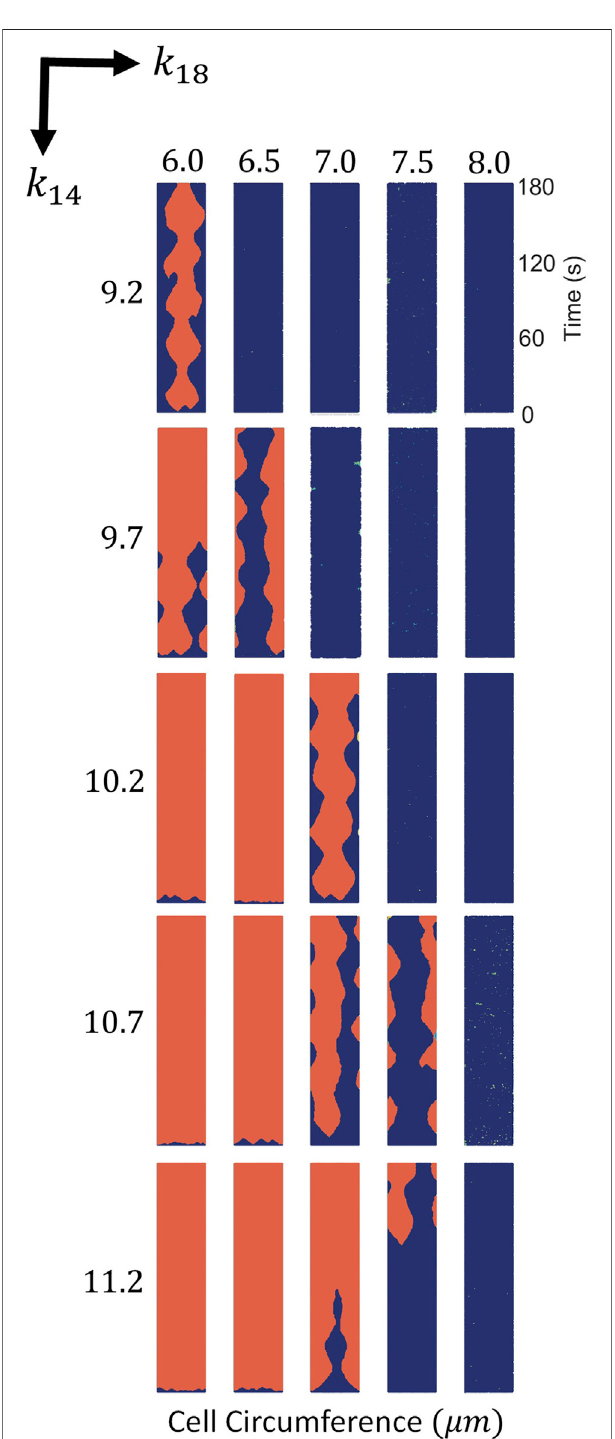
FIGURE 2 | Spatio-temporal plots of P (in red) for different values of k 14 and k 18 .Foreachpaneltimesgoesfrombottomtotopandhorizontaldirection corresponds to membrane position in the cell circumference. Variances of noise intensity were fi xed at σ R = 0.04 and σ P =